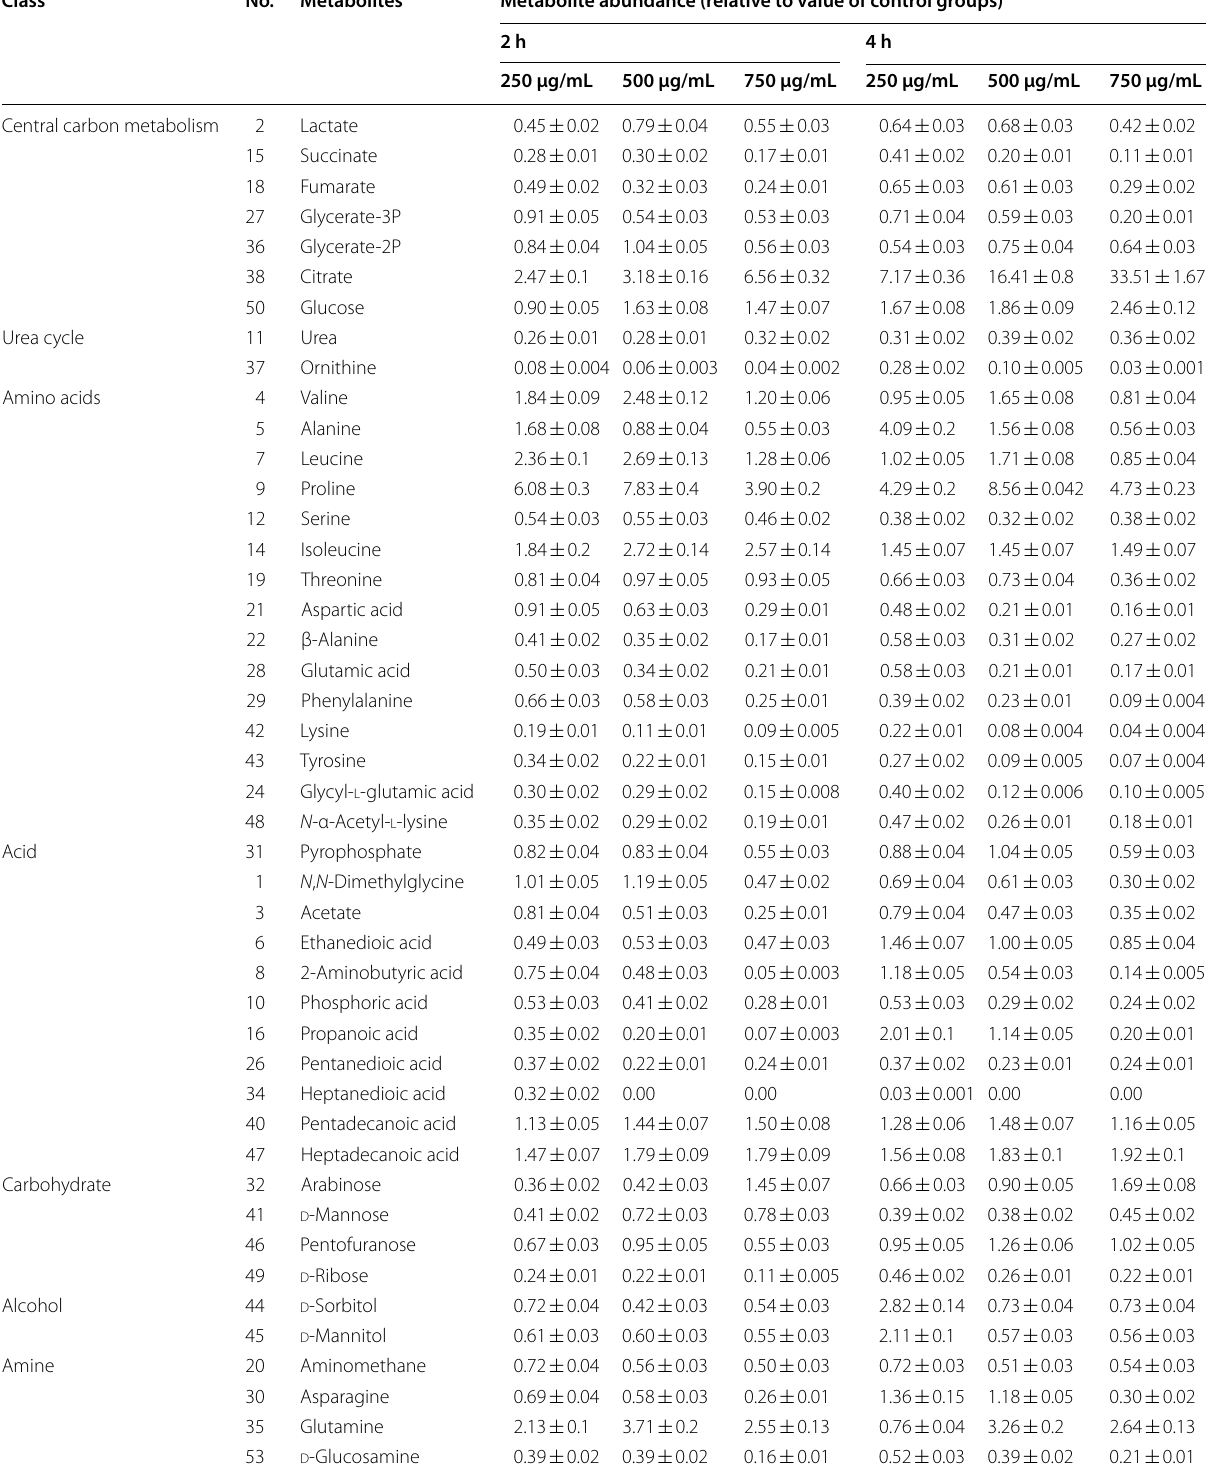
Table 1 Identification of intracellular metabolites of S. aureus Class No.